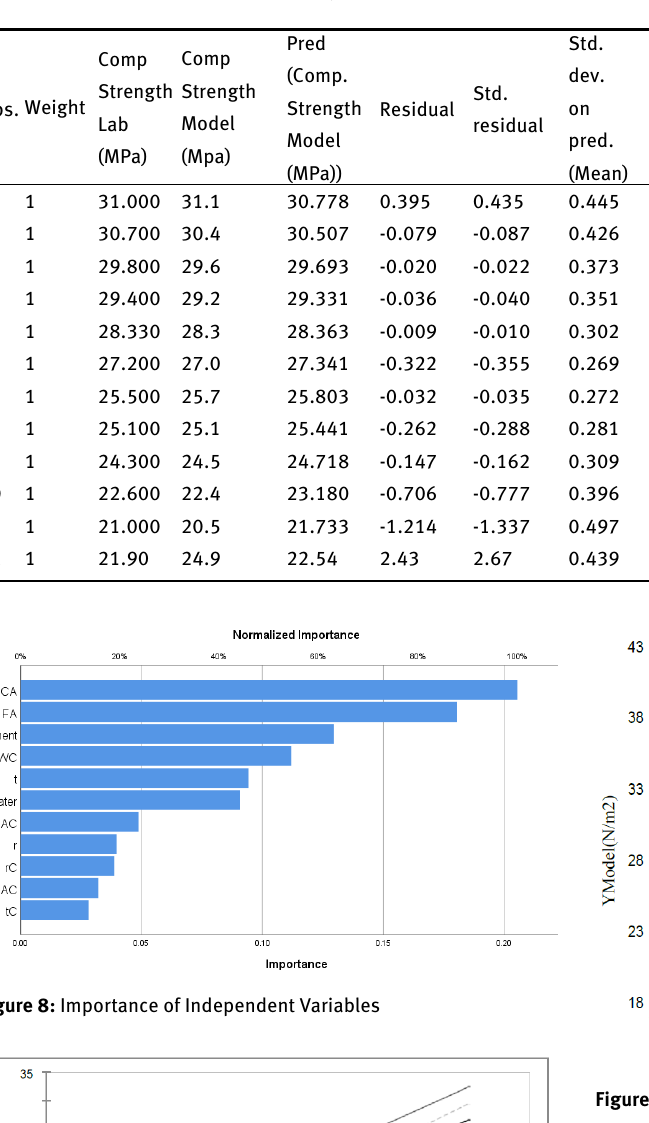
Table 13: Predictions and residuals (Compressive Strength Model (MPa))